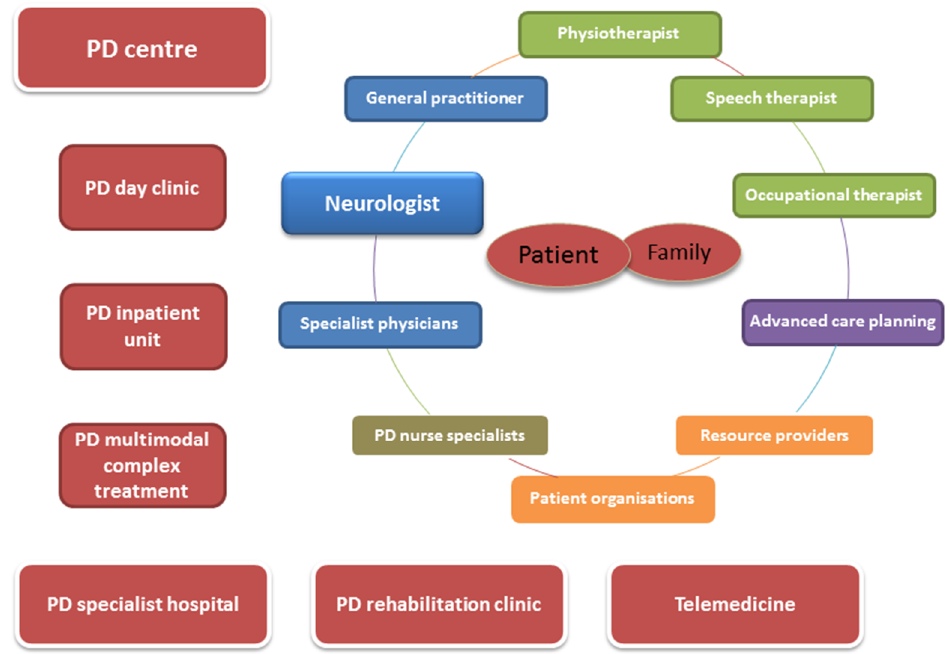
Figure 1. Schematized representation of common players and structures in a local supply network.